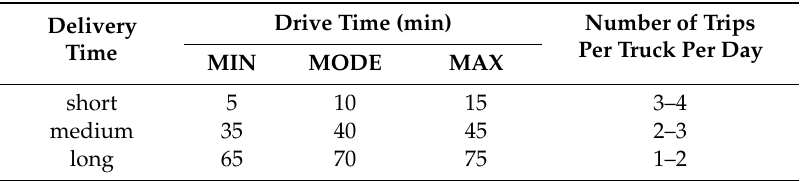
Table 2. One way truck delivery time.